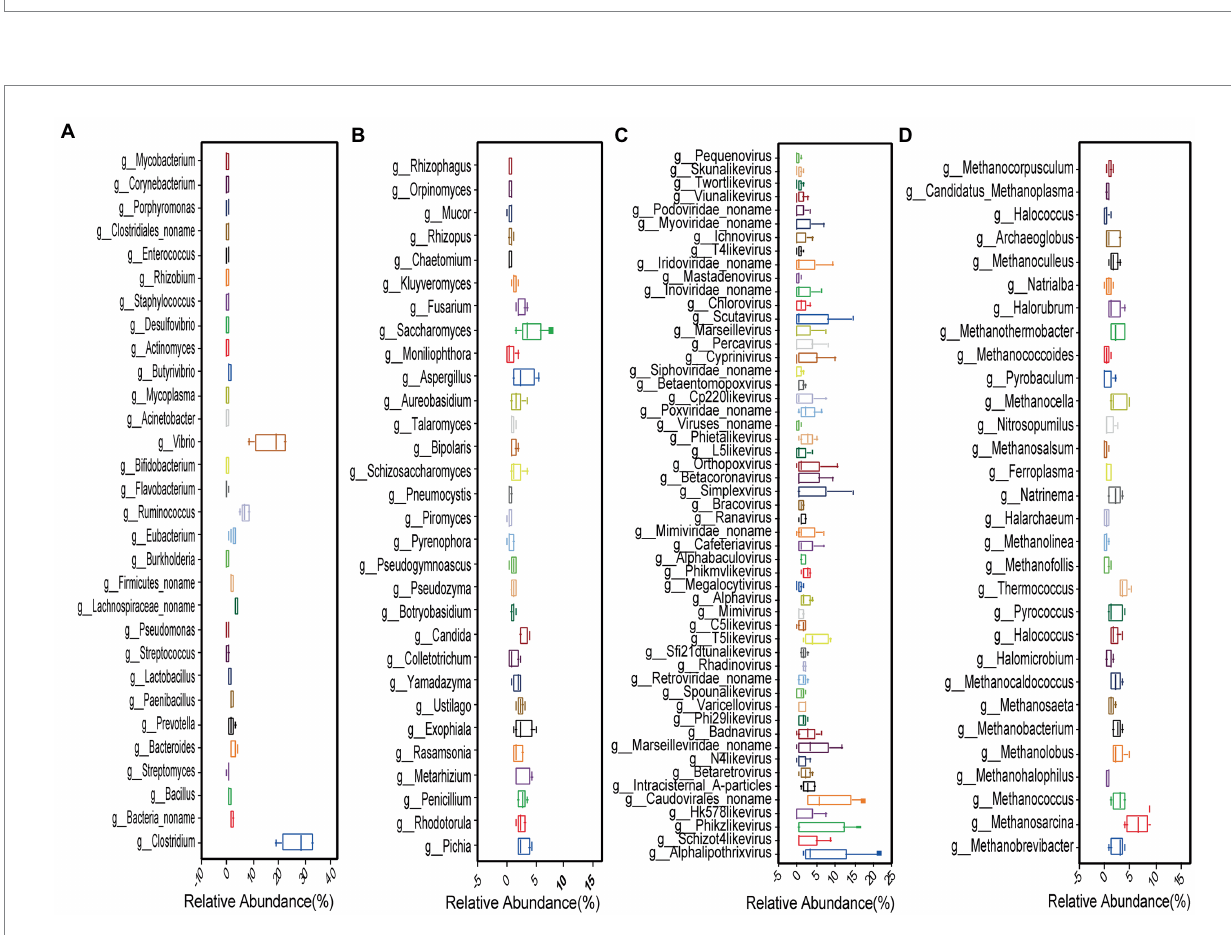
FIGURE 3 Top 30 most abundant (A) bacteria; (B) fungi; (C) viruses; and (D) archaea